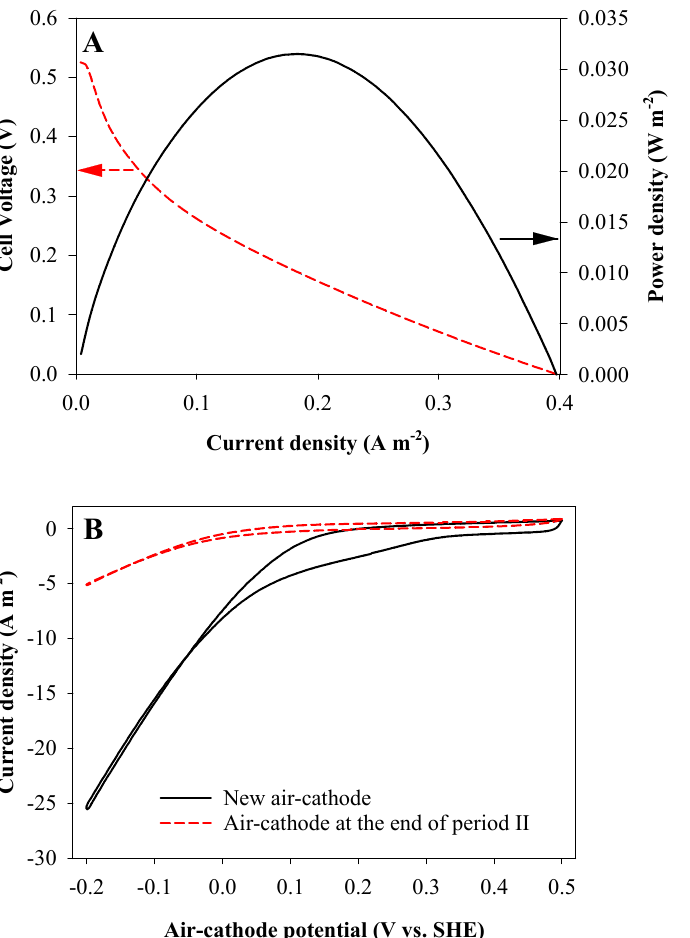
Figure 2. Electrochemical techniques for the characterization of the FC; ( A ): polarization curve of the FC and ( B ): cyclic voltammetry of the air-cathode at the end of period II and of a new piece of air-cathode. Scan rate of both analyses: 1 mV s − 1 .